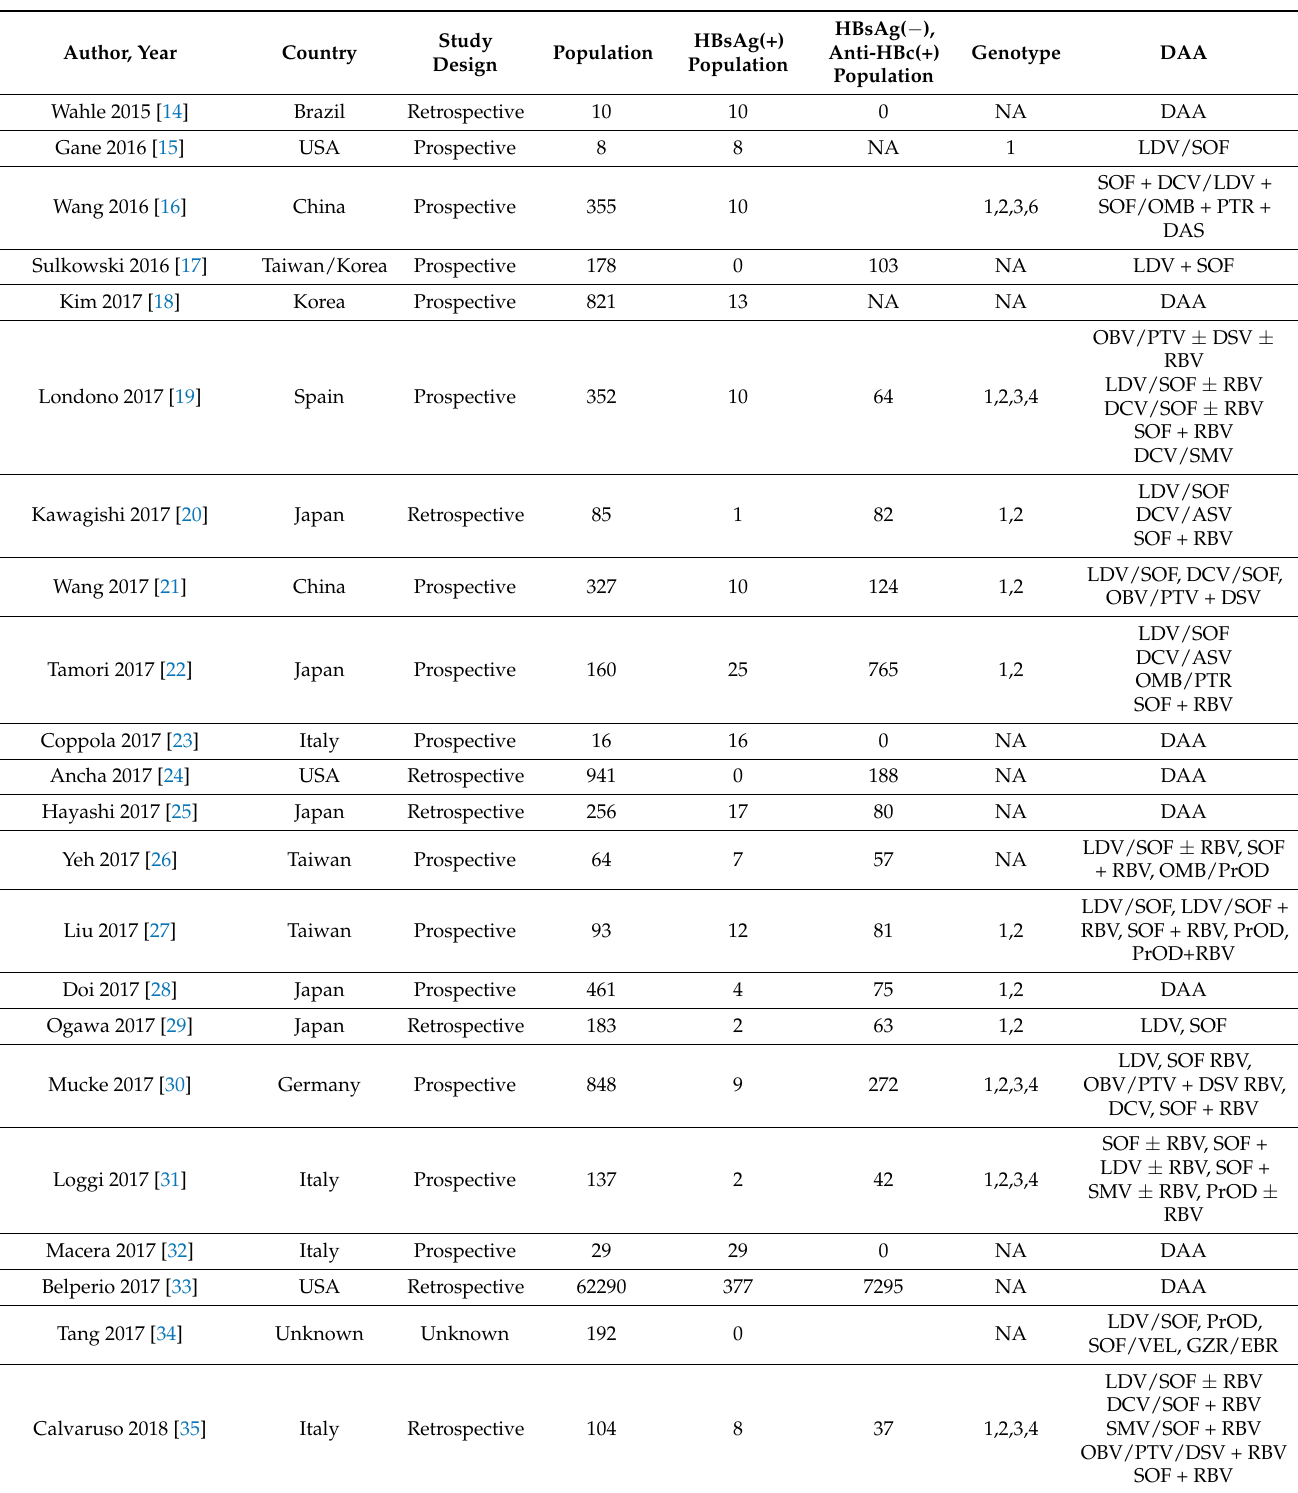
Table 1. Characteristics of studies in the final analysis ( n =